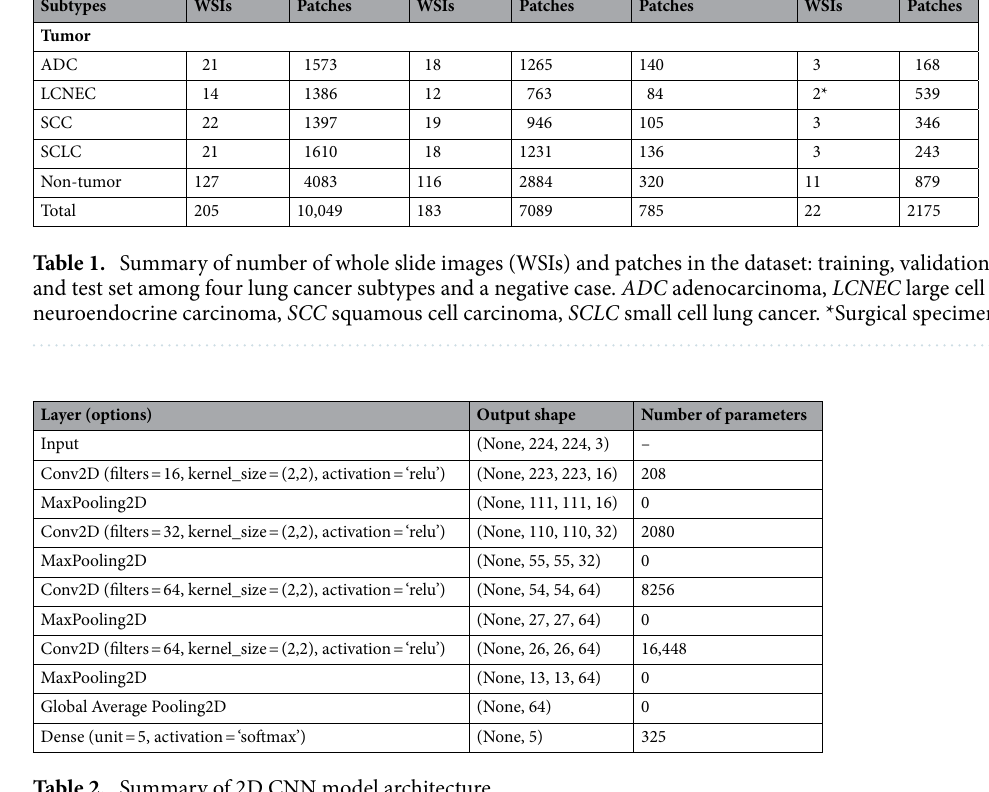
Table 2. Summary of 2D CNN model